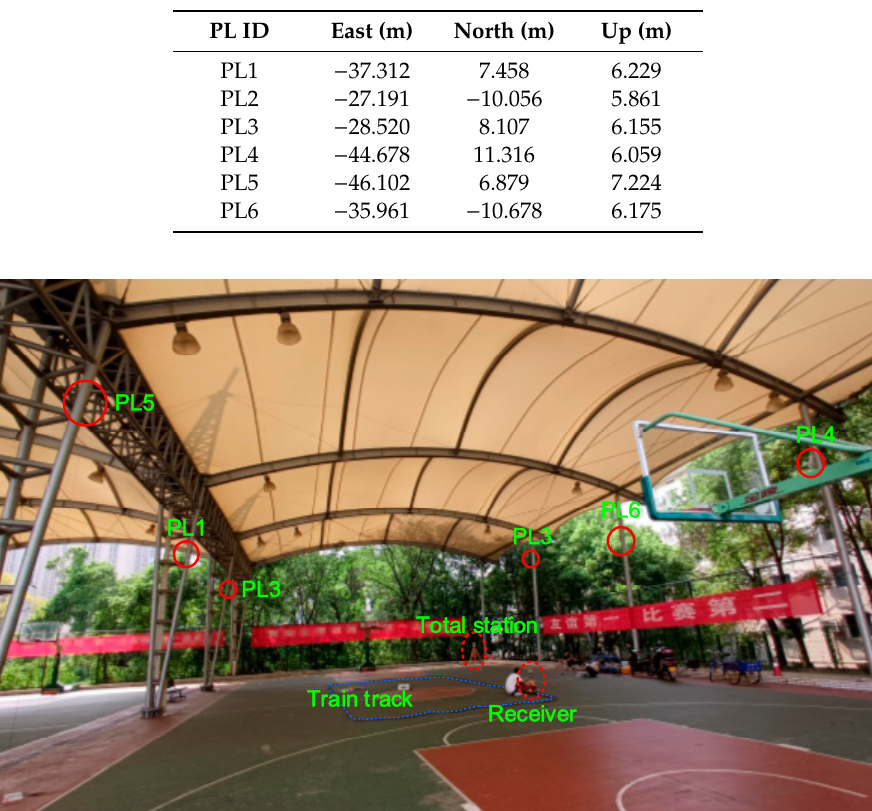
Figure 10. Six pseudolites and the user receiver in the test field.